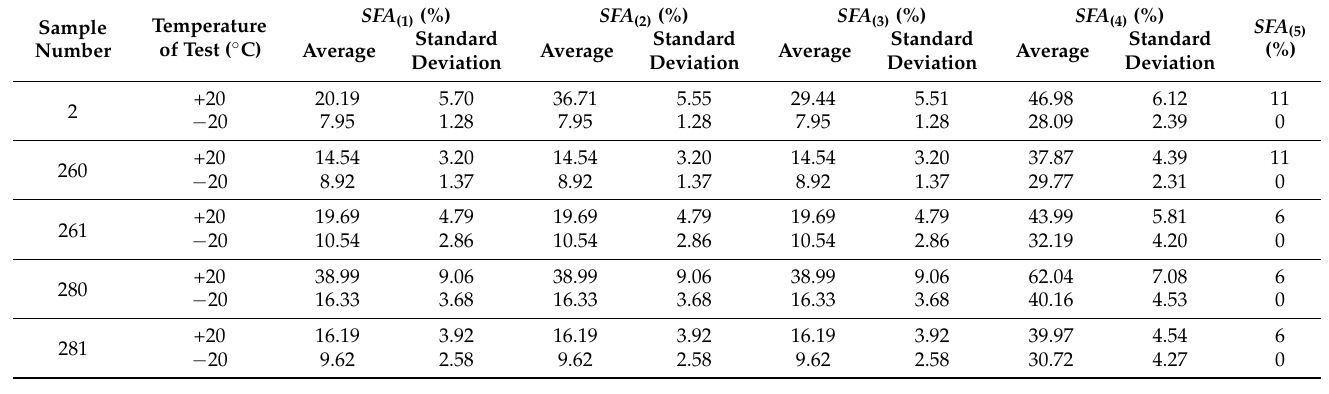
Table 5. Values of the SFA ( n ) (%) parameters determined for X20Cr13 steel, determined on impact toughness test fractures obtained during this research.